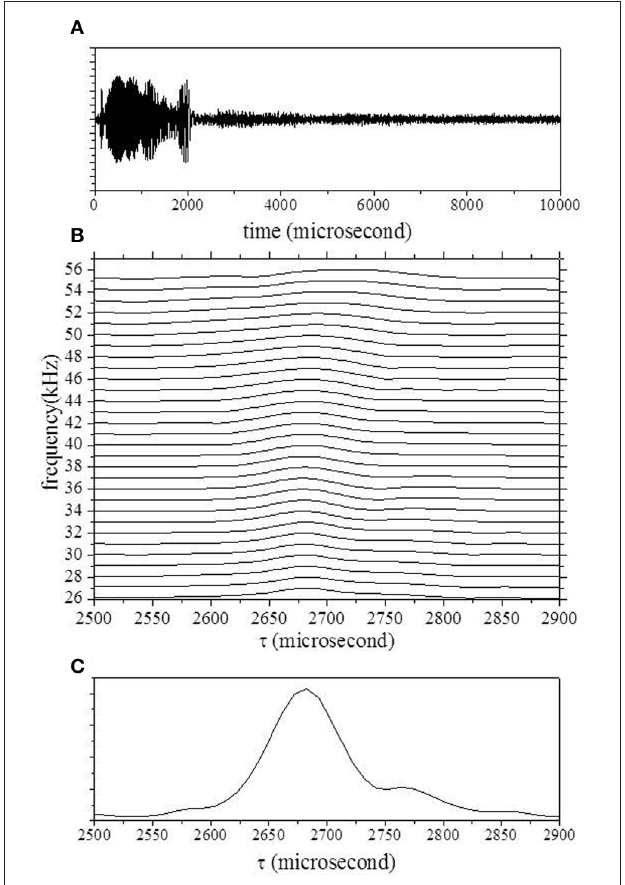
FIGURE 3 | (A) Emission waveform. (B) Emission spectrogram, computed by convolution of the Gaussian chirplets. (C) The temporal emission pattern W emi corresponds to the spectrogram for one bandpass filter (with a center frequency of 30kHz).